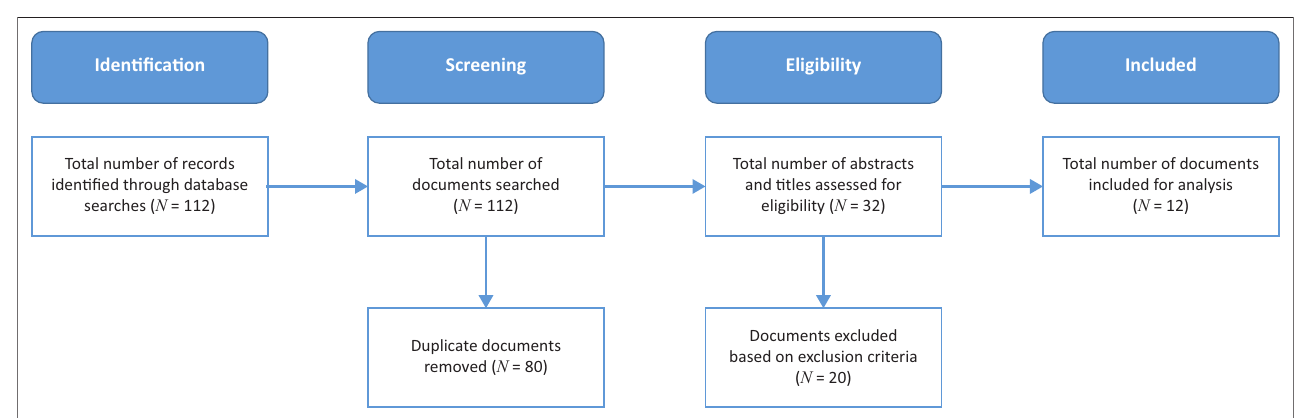
Total number of records iden(cid:31)fied through database searches ( N = 112)